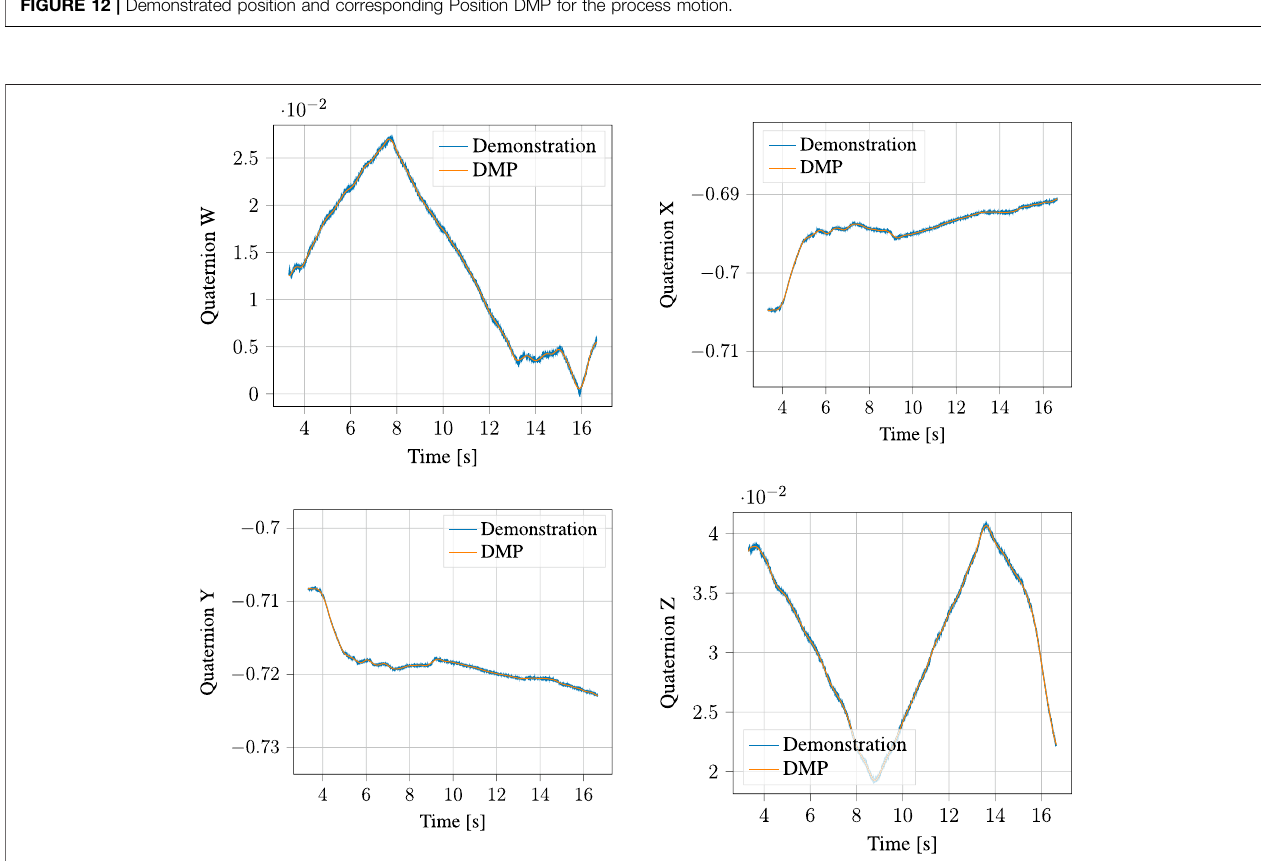
FIGURE 13 | Demonstrated orientation (quaternion) and corresponding Quaternion DMP for the process